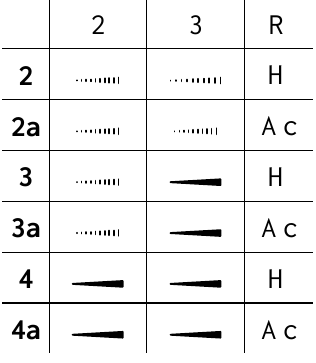
Figure 1. Flavan-3-ols identified from seeds of Paullinia cupana . Epicatechin ( 2 ), catechin ( 3 ), and ent -epicatechin ( 4